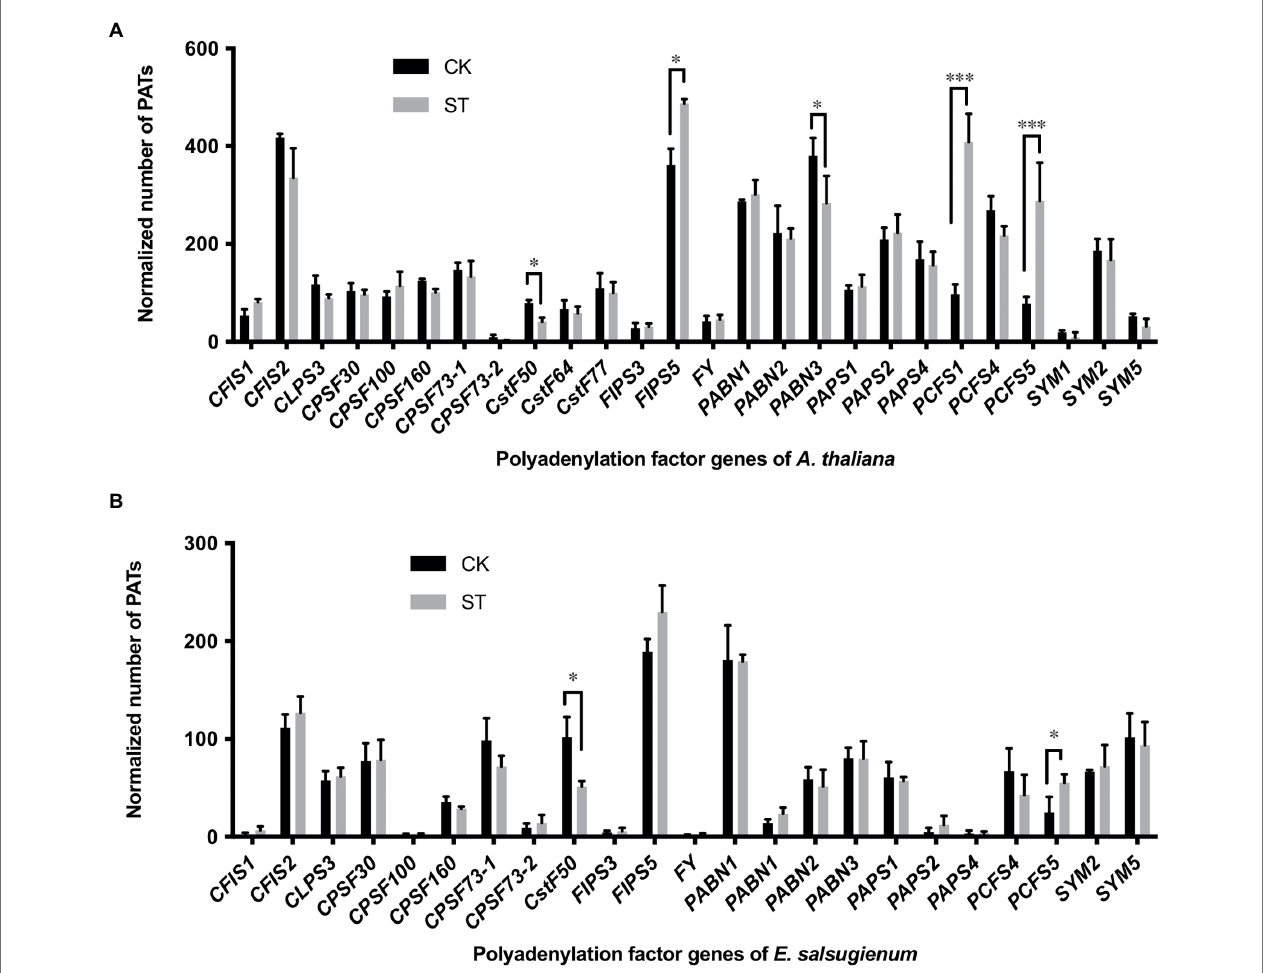
FIGURE 7 | Gene expression levels of polyadenylation factors in Arabidopsis (A) and Eutrema (B) . CK, control; ST, salt stress. Statistical significance was determined by one-way ANOVA, * p < 0.05, *** p <